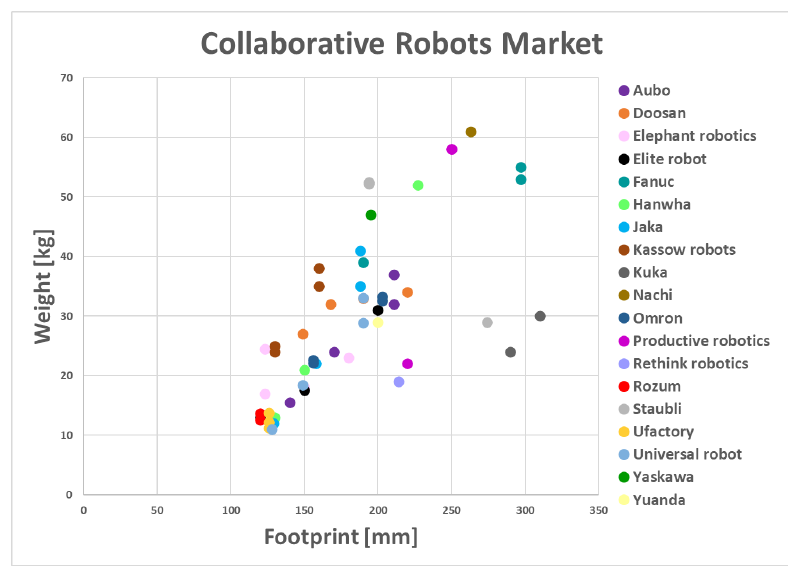
Figure 2. Collaborative Robots Market: weight vs. reach.